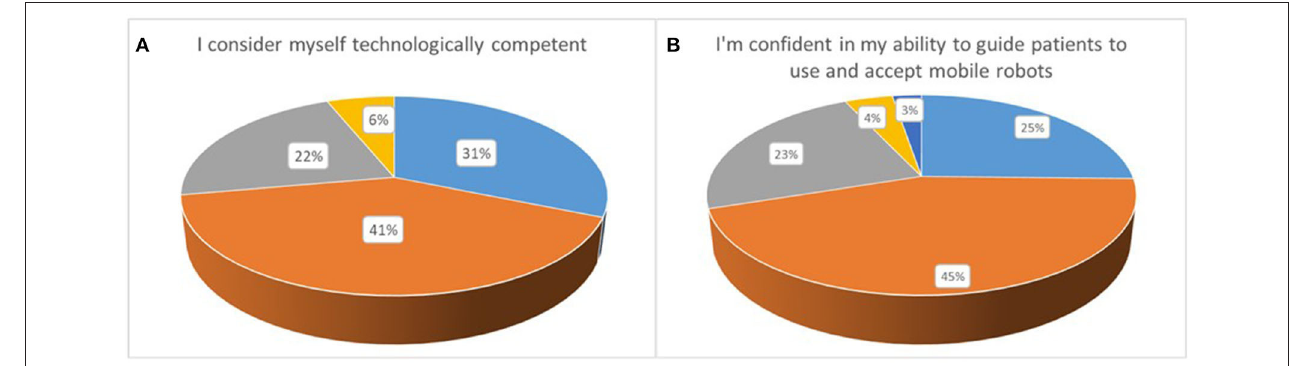
FIGURE 2 | (A,B) Perceived behavioral